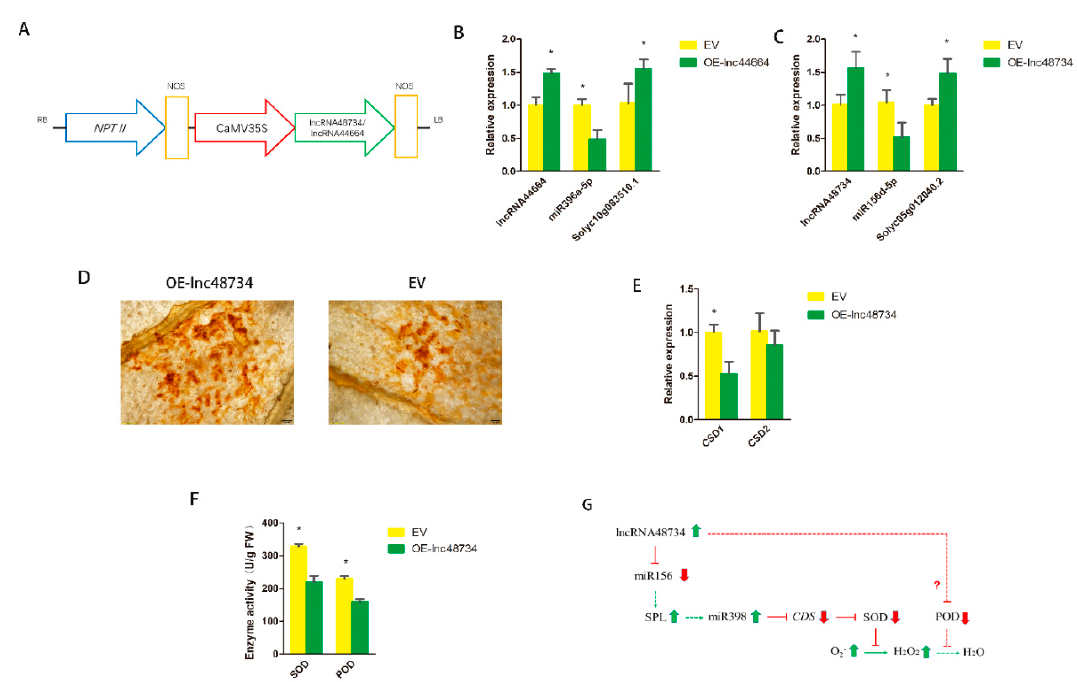
Figure 6. Function verification of lncRNAs. ( A ) Schematic diagram of the gene cassette containing lncRNA48734 and lncRNA44664. ( B ) qRT-PCR analysis of lncRNA44664, miR396a and the target genes in the EV (empty vector) and OE-lnc44664 tomato plants. ( C ) qRT-PCR analysis of lncRNA48734, miR156d and the target genes in the EV and OE-lnc48734 tomato plants. ( D ) DAB staining of the leaves of EV and OE-lnc48734 tomato plants for H 2 O 2 after inoculation with Agrobacterium after 3 days. Scale bars = 200 µ m. ( E ) qRT-PCR analysis of CSD1 and CSD2 in tomato plants. ( F ) The enzyme activity of SOD and POD of EV and OE-lnc48734 tomato plants. ( G ) The predictive model of lncRNA48734-ROS accumulation interaction network involved in tomato. Arrows indicate positive regulation, and blunt-ended bars indicate inhibition. All data are the means ± SD of three independent experiments. * indicate a significant difference at the p = 0.05 level.